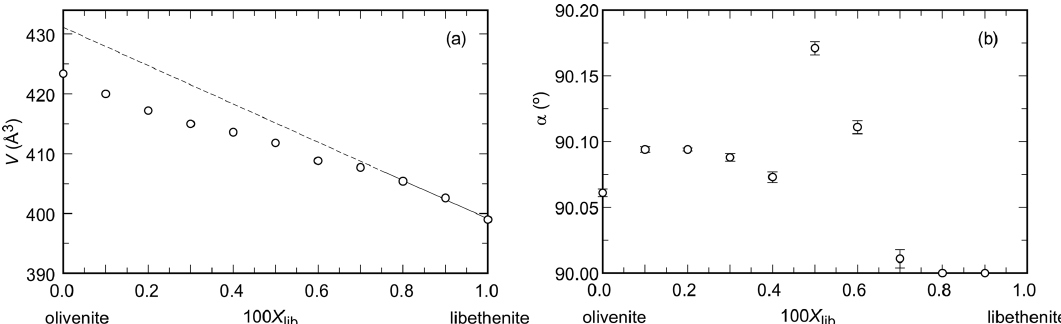
Figure 1. Variations in (a) unit-cell volume and (b) the monoclinic angle α (note the non-standard monoclinic setting, described in the